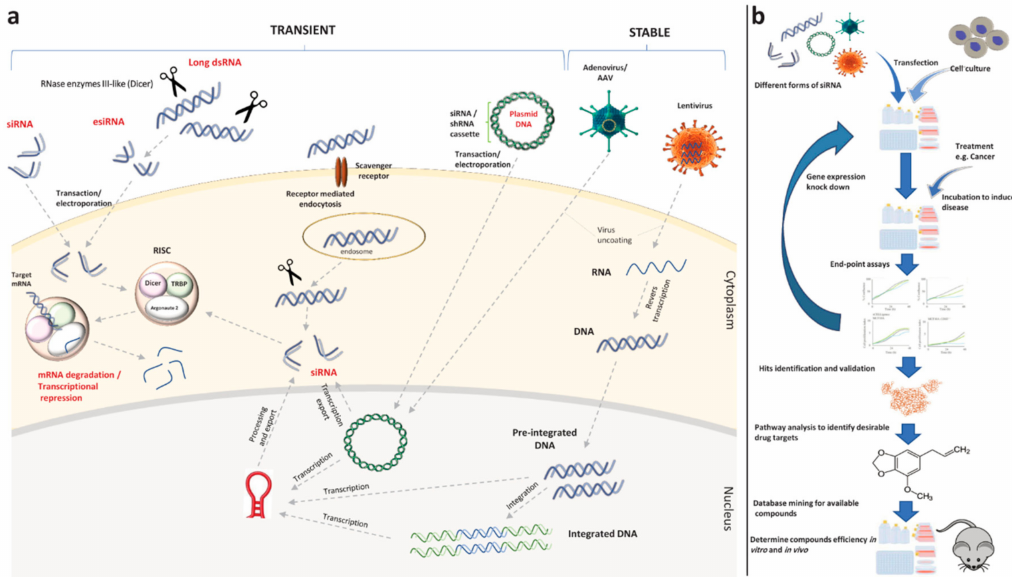
Figure 3. Various RNA interference (RNAi) constructs used for temporary or permanent gene silencing and a general workflow of small interfering RNA (siRNA) screening towards drug repositioning (adapted from [72]). ( a ) siRNA, endoribonuclease-prepared siRNA (esiRNA), and long double-strand RNA(dsRNA),asnakedRNAs, canbeintroducedtothecellthroughmanypathways, suchaslipid-based transfection reagents or electroporation, or active uptake by target cells through receptor-mediated endocytosis. Inside the cytoplasm, dsRNA is cleaved by endonucleases. Then, the obtained